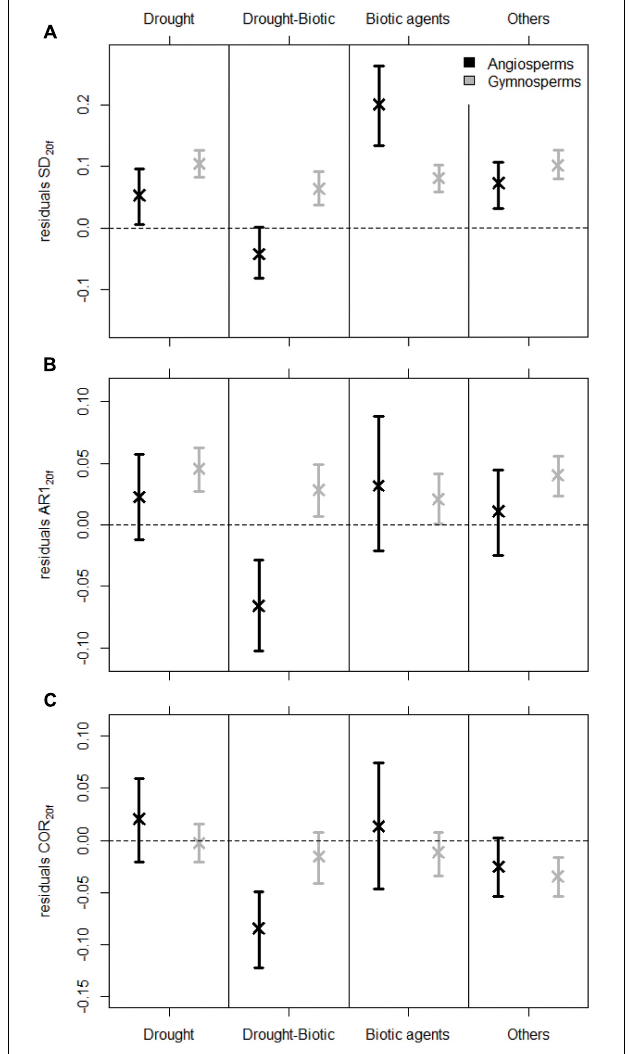
FIGURE 3 | Variation in the residuals of SD (A) , AR1 (B) , and COR (C) calculated over the last 20-year period of the detrended ring-width time series preceding tree death (resSD 20 f , resAR1 20 f , and resCOR 20 f ) among mortality sources and species groups. Error bars depict 95% confidence intervals of the mean residuals, which were determined from 500 bootstrap resamplings of the original